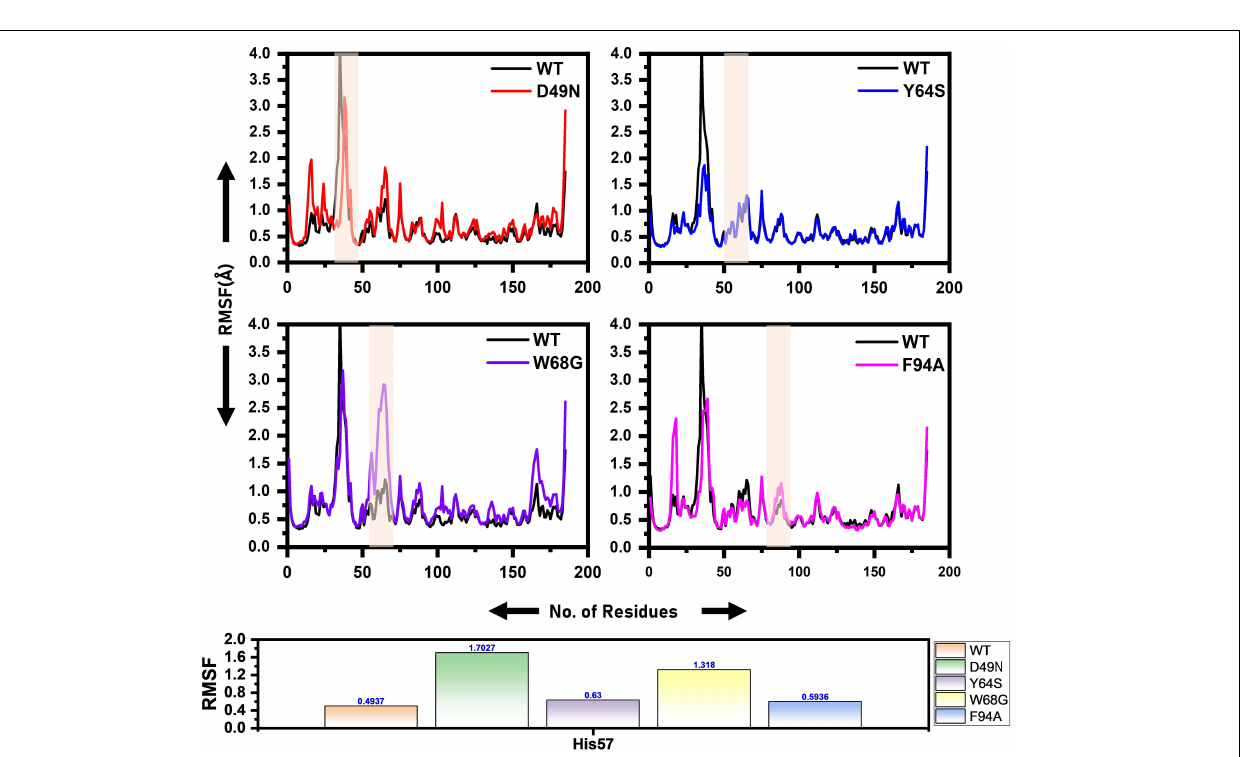
FIGURE 3 | RMSF of the wild and mutants’ complexes. The RMSD of each mutant is superimposed over RMSF of the wild type. The x-axis shows residues number, while the y-axis shows RMSF in Angstrom. Shadowed regions depict enzyme amino acids stretch highly affected by the mutation.